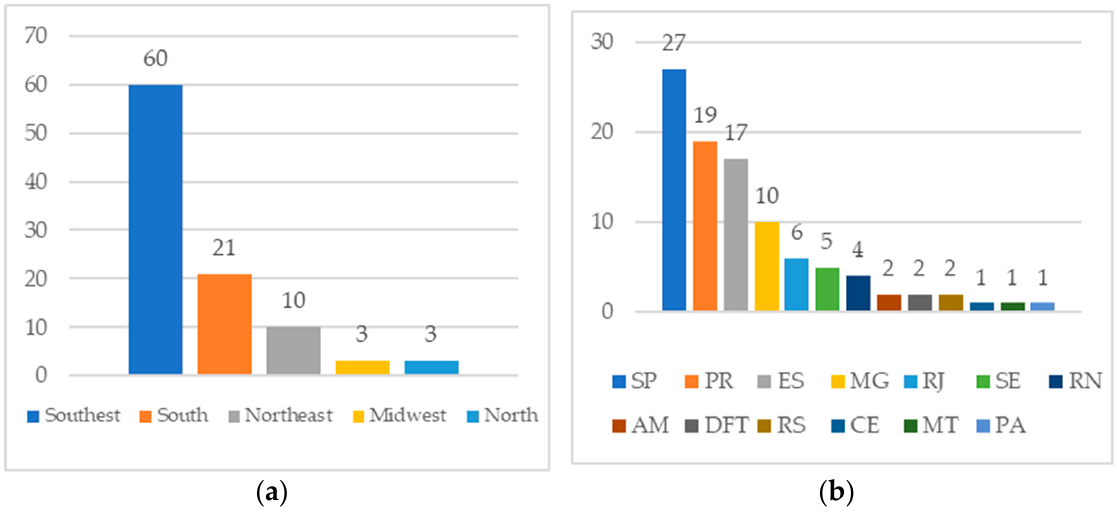
Figure 2. ( a ) Number of Decisions per Region; ( b ) Number of Decisions per State. Most cases were found in appeal courts from states located in the southeastern and southern regions of Brazil, which correspond to the regions with the highest demographic density and Human Development Index in the country [31]. With regard to access to water, while more than 90% of the population in southeastern and southern regions have access to water supply, the numbers for the northern and northeastern regions are 47.6% and 73.4%, respectively [32]. The northeastern region is by far the most affected by water rationing and interruptions in water supply services [32]. Still, only 10 out of 97 cases come from this region (Figure 2a). However, this is not to say that problems related to access to water are not to be found in the southeastern and southern regions, where vulnerable groups, such as those living in irregular land occupations, are hardest